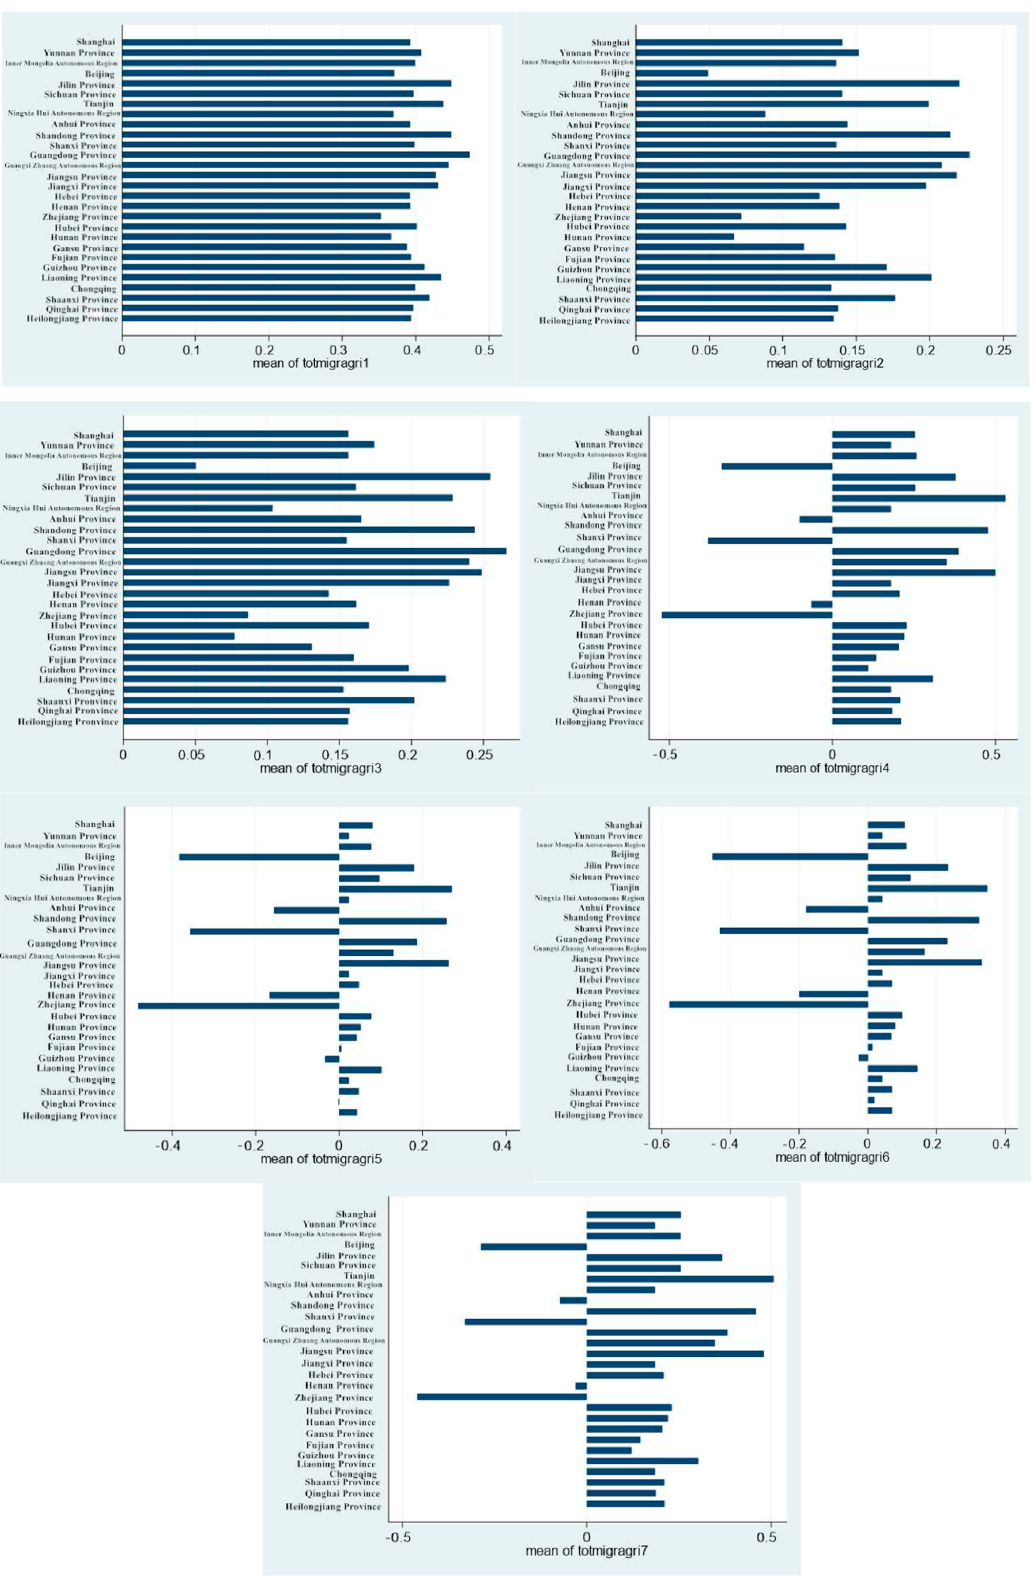
Figure 1. The total e ff ect ( = random e ff ect + fixed e ff ect) of the interaction term combining mobility and agricultural hukou on health di ff erences by interview locations in Models 1 to 7. (Words in the longitudinal axis represent the names of the survey